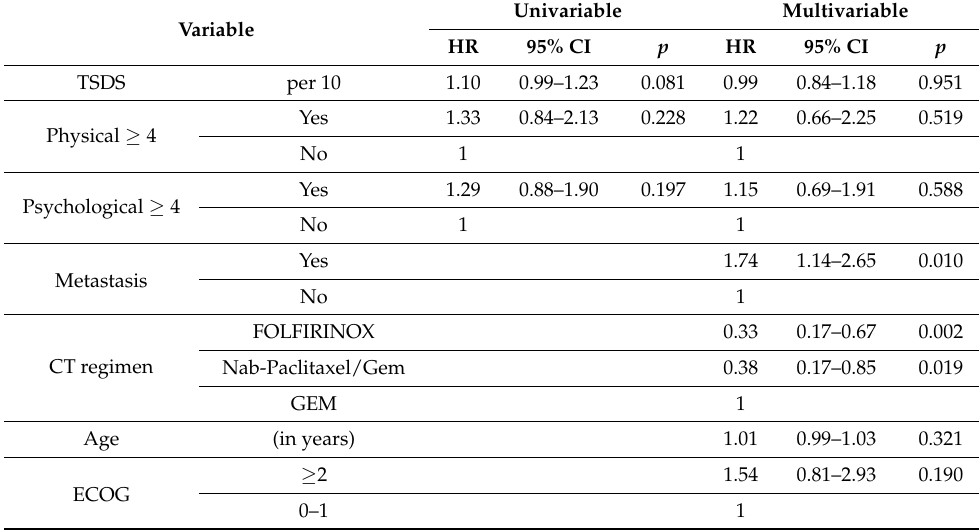
Table 3. Cox regression predicting survival (baseline measures of TSDS, Physical, and Psychological Scales).